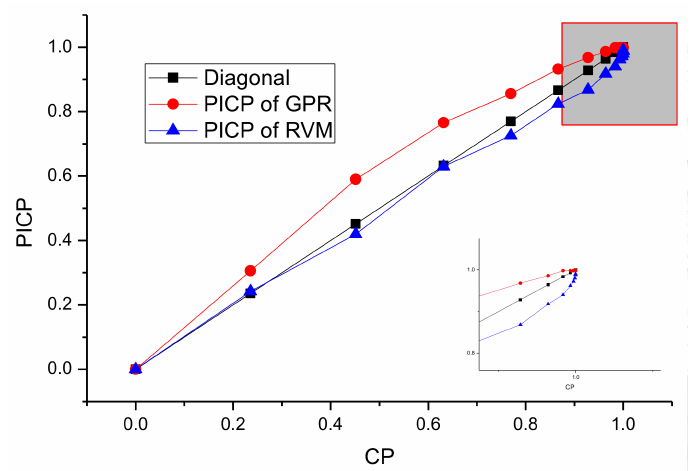
Figure 12. ROC-PI curves of RVM and GPR for solar array temperature